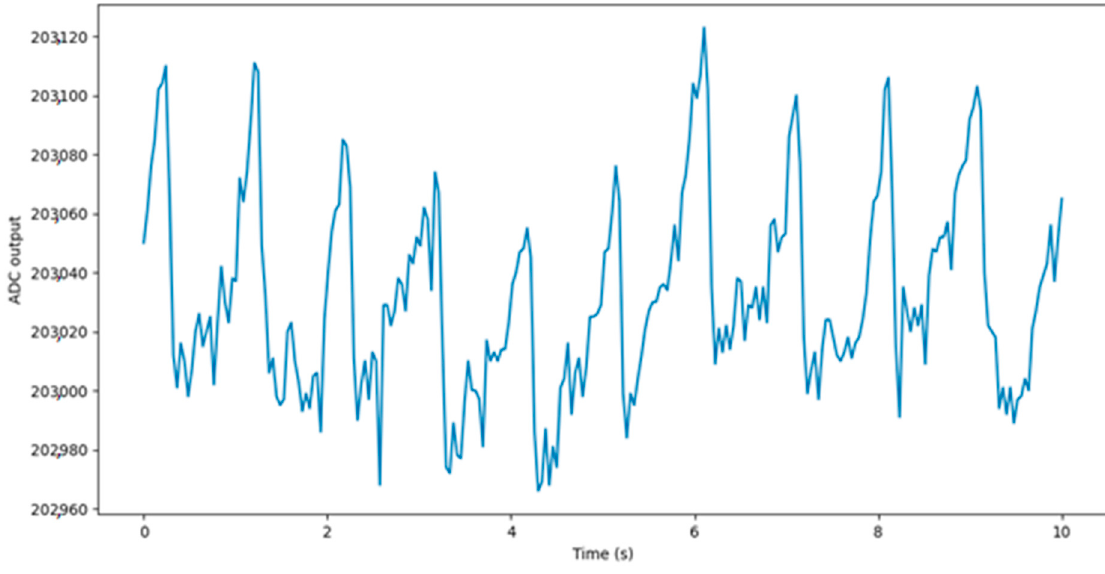
Figure 4. Raw PPG Figure 4. Raw PPG signal.